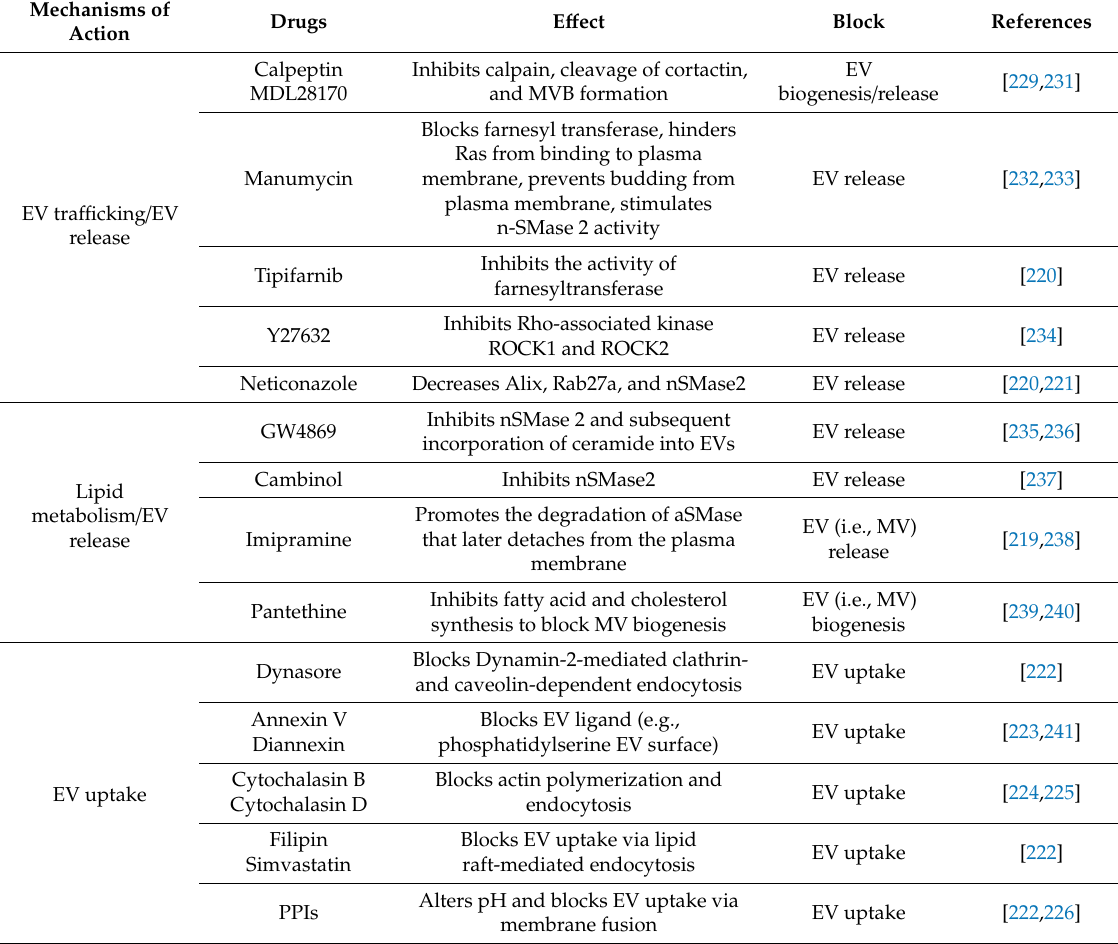
Table 2. Regulators of EV biogenesis / release and uptake from